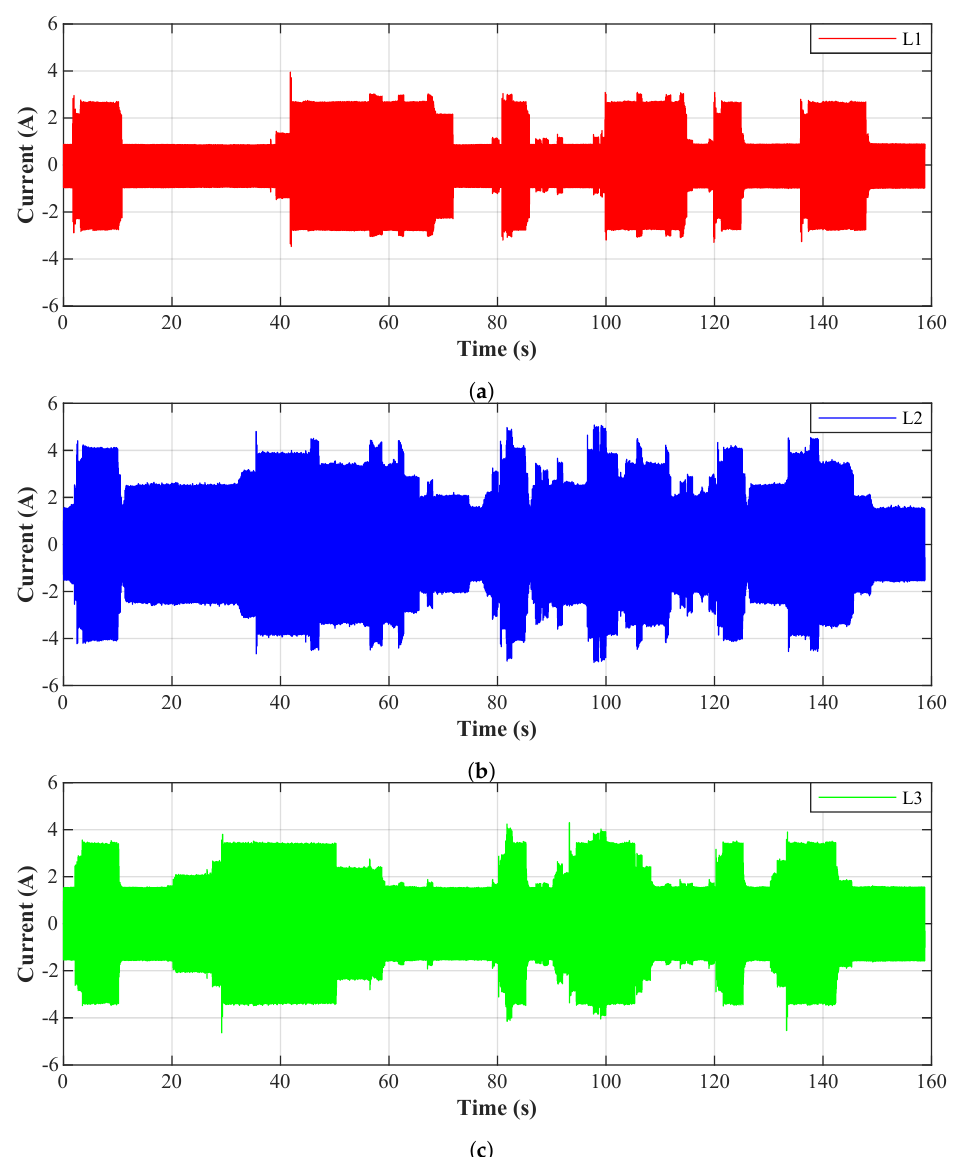
Figure 23. Current waveform envelopes of the test polygon. ( a ) L1—phase 1, ( b ) L2—phase 2, and ( c ) L3—phase